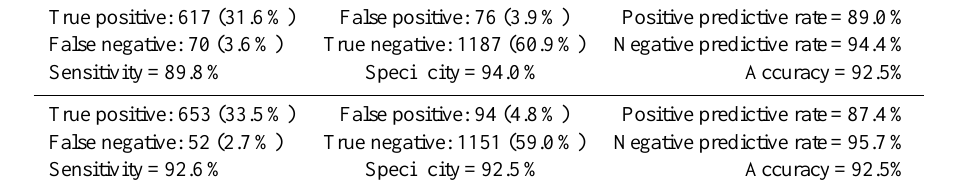
Table 1. Confusion matrix of the algorithm tested on the 1950 independently verified polygons larger than 1000m 2 , from an inventory of landslides triggered by the 1994 Northridge earthquake. Positive and negative conditions refers to polygons considered amalgamated and correct, respectively. Therefore, false positives are correctly mapped polygons erroneously identified as amalgams whereas false negatives are amalgams that remain undetected by the algorithm. Values are given as number of landslides and percent of the total population. The algorithm was run with the following parameters: resolution 2m, K c = 2, S c = 12 ◦ and RB c = 5 for the upper part of the table and RB c = 6 for the lower